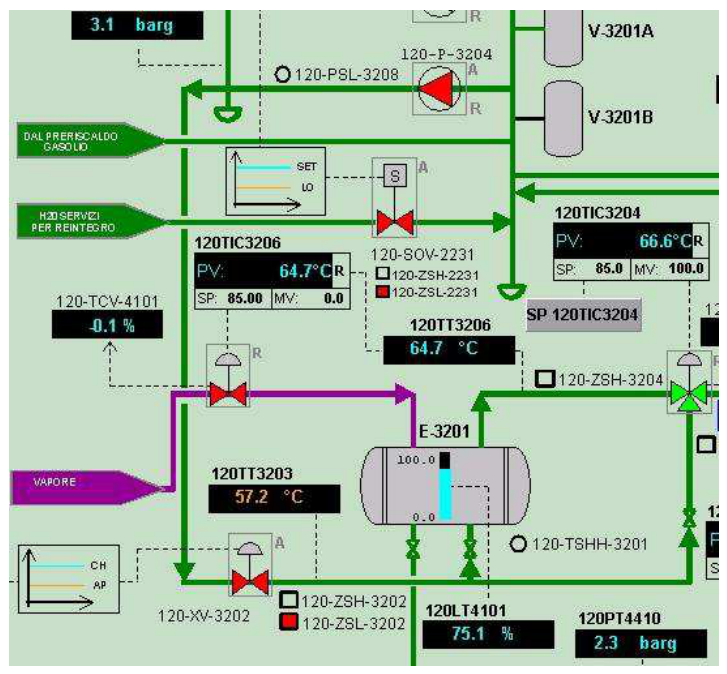
Figure 2. Overview of part of the renewable energy plant used for experimental